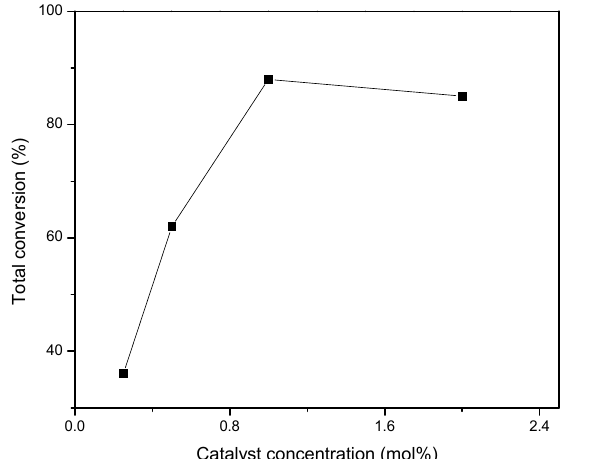
Figure 2. Total conversion of styrene to its oxygenates catalyzed by 3 , at varying catalyst concentrations.